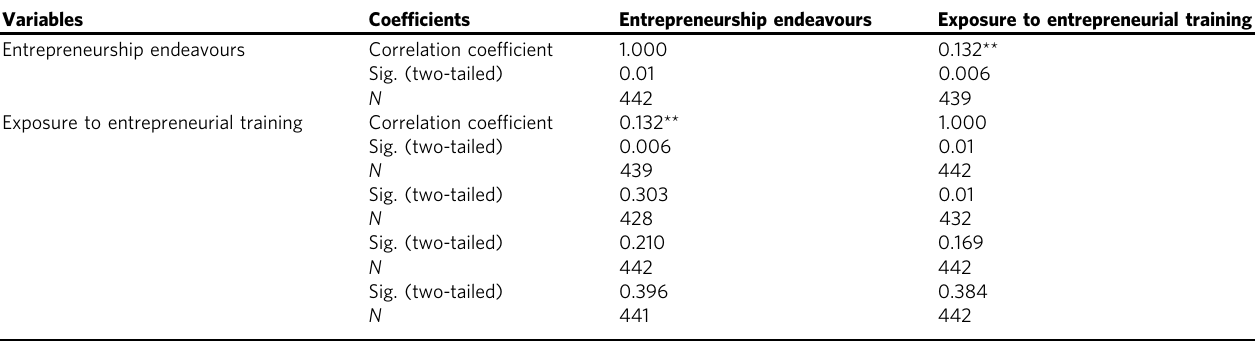
Table 4 Spearman ’ s correlation